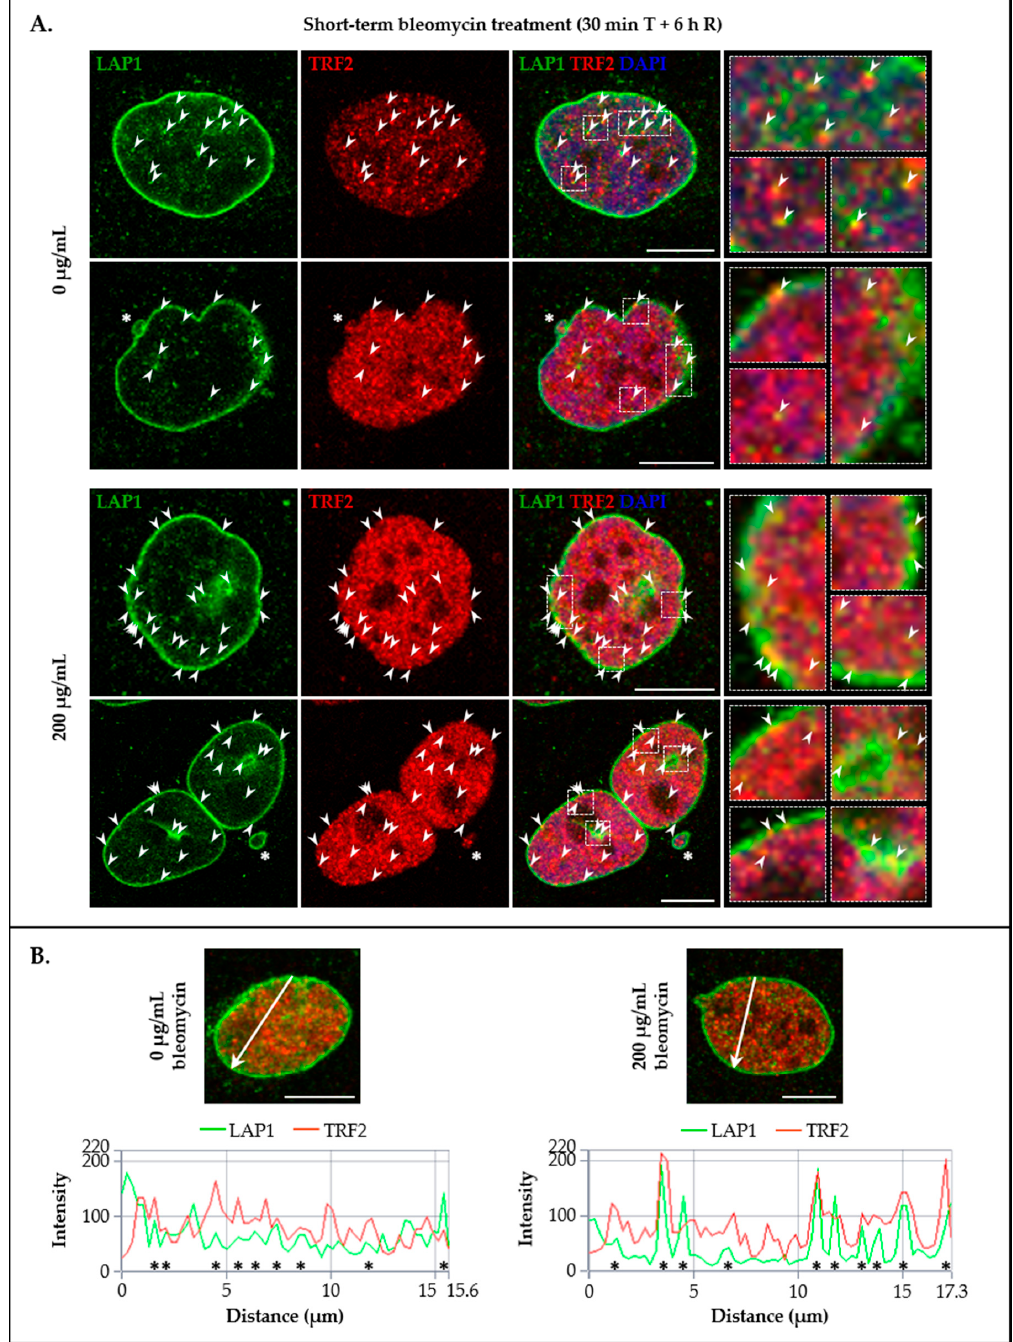
Figure 8. Analysis of the subcellular distribution of LAP1:TRF2 complex in the human HeLa cell line. ( A ) Immunolocalization of LAP1 (green) and TRF2 (red) in control conditions and after DNA damage induction through cell exposure to 200 µg/mL of bleomycin for 30 min (T), followed by 6 h of recovery (R). Upon fixation, HeLa cells were immunostained with LAP1- and TRF2-specific primary antibodies linked to AF 488- and AF 594-conjugated secondary antibodies, respectively, and incubated with mounting medium containing DAPI (blue). Image acquisition was performed using an LSM 880 confocal laser scanning microscope with Airyscan. Representative microphotographs (one section